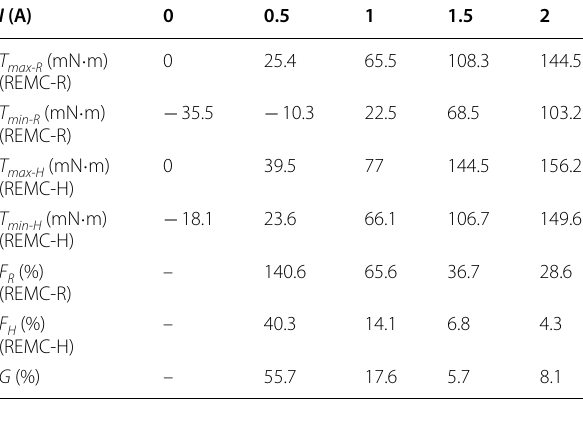
Table 2 Analysis of experimental results of torque–angle